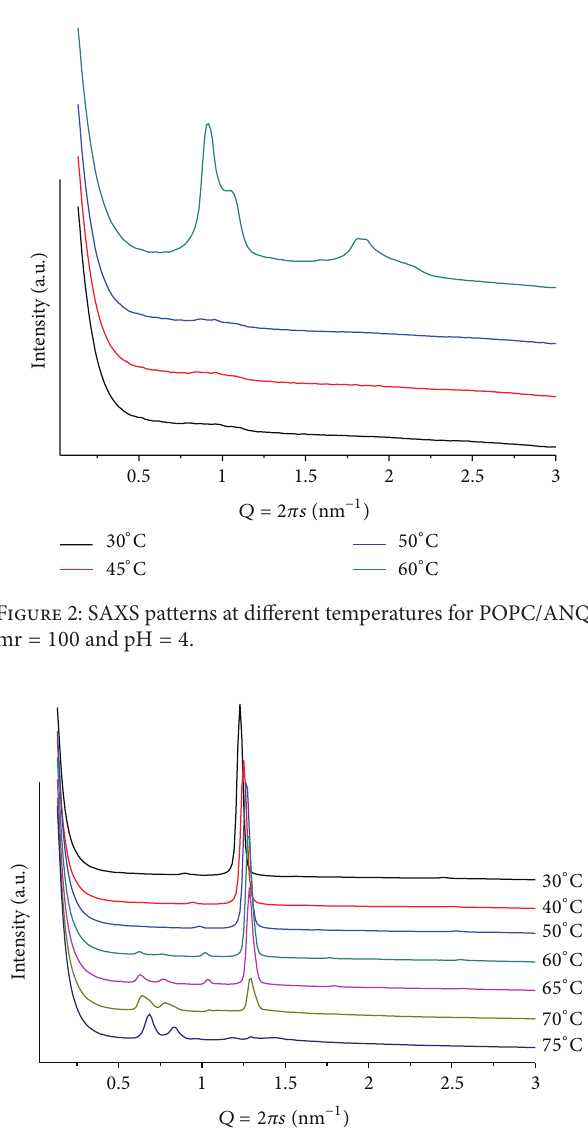
Figure 3: SAXS patterns at different temperatures for POPE/ANQ, mr = 100 and pH = 4 . Note peaks at 𝑄 ≤ 1 associated with a cubic